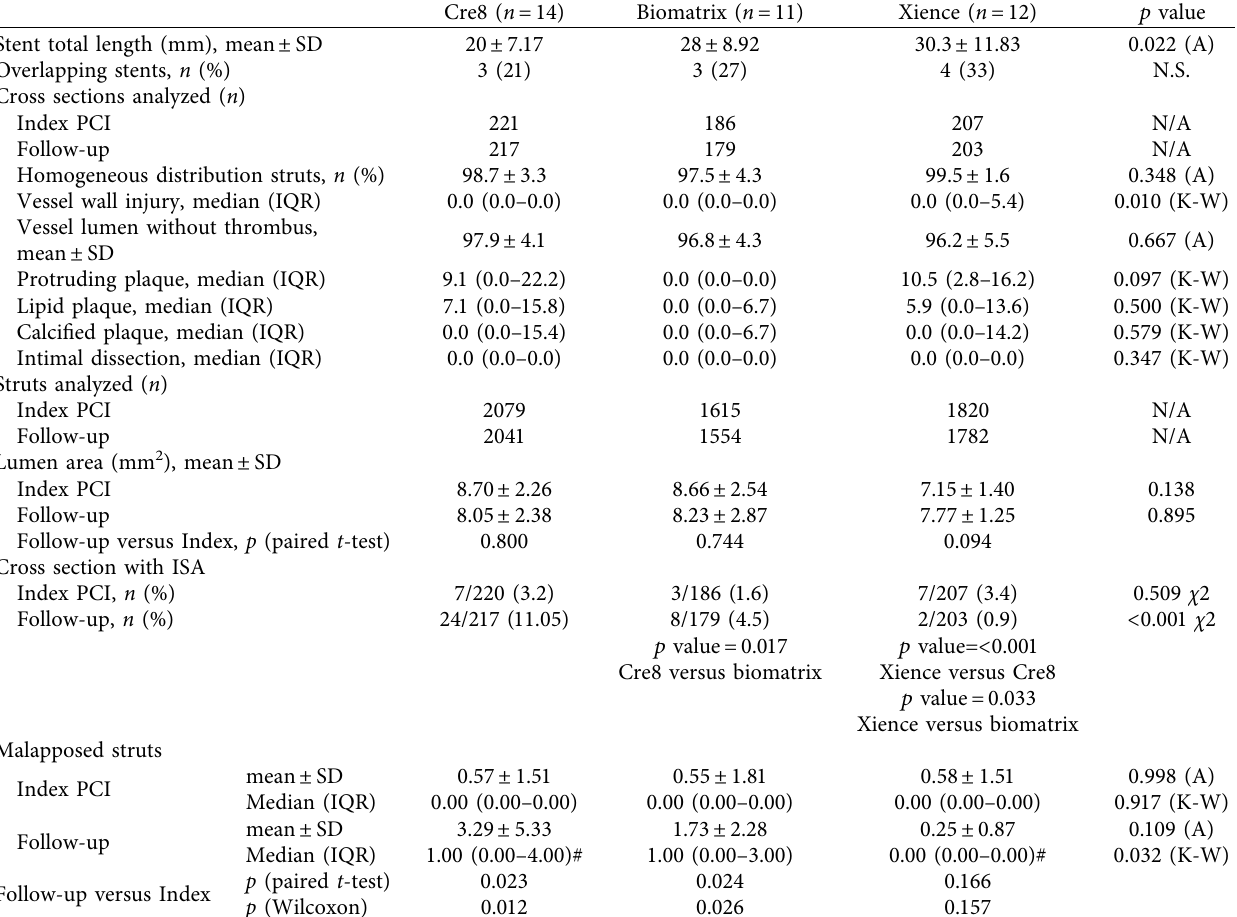
Table 3: OCT analysis at the index PCI and comparison with OCT analysis at 6-month follow-up.